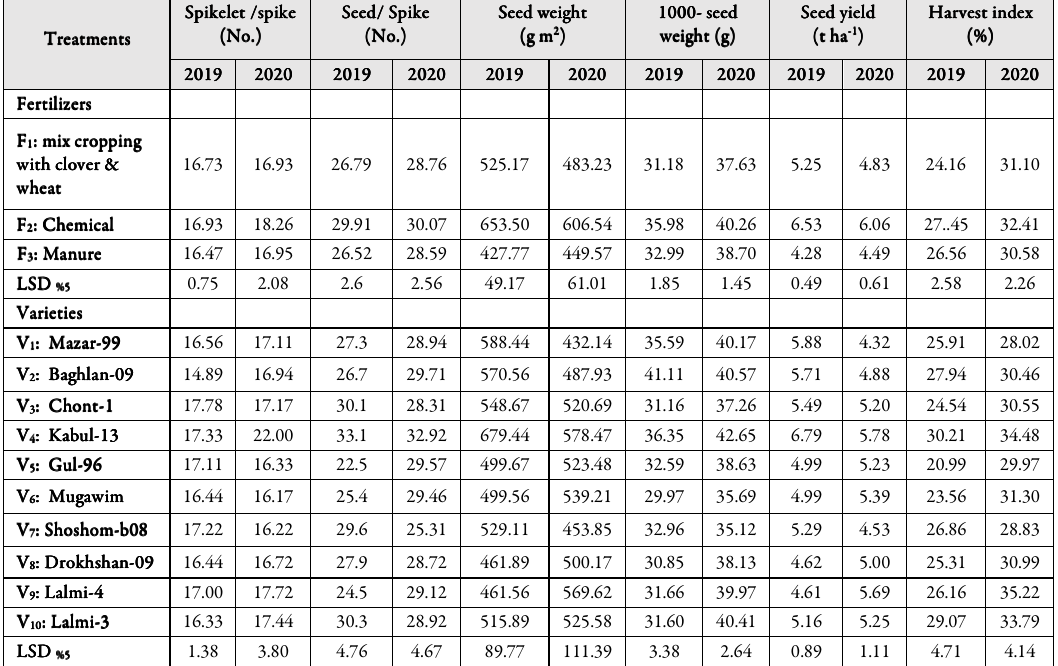
Table 6. Means comparison for the effect of fertilization and different wheat varieties on reproductive